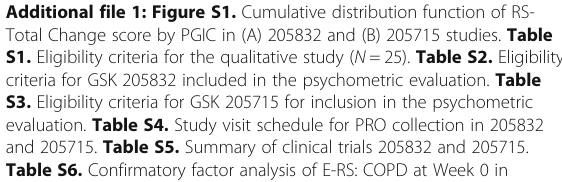
S3. Eligibility criteria for GSK 205715 for inclusion in the psychometric evaluation. Table S4. Study visit schedule for PRO collection in 205832 and 205715. Table S5. Summary of clinical trials 205832 and 205715. Table S6. Confirmatory factor analysis of E-RS: COPD at Week 0